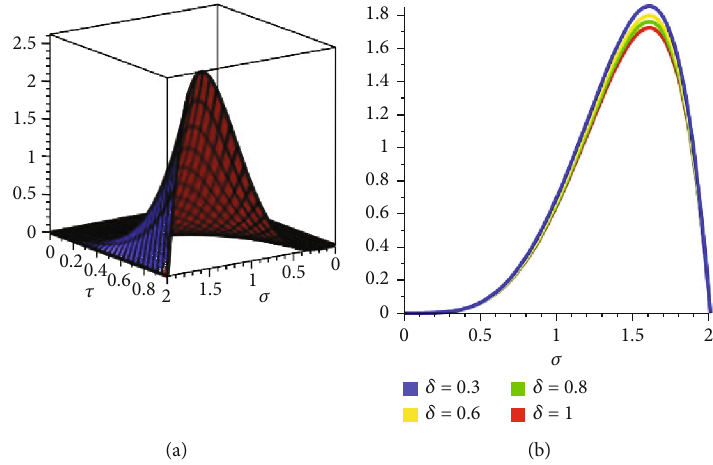
Figure 3: (a) 3D and (b) 2D plots for di ff erent fractional value of δ for Example 5.1.